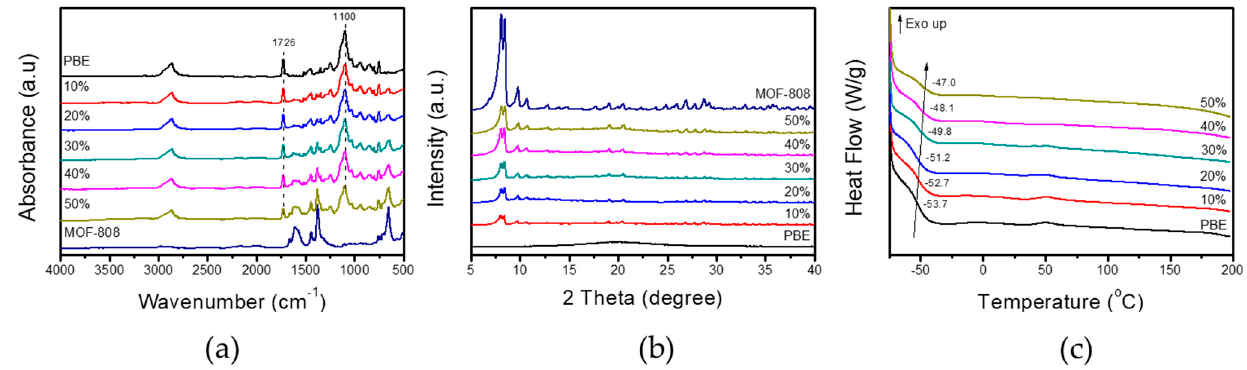
Figure 2. ( a ) FT-IR spectra and ( b ) XRD patterns of the PBE comb copolymer, MOF-808 nanoparti- cles, and PBE/MOF MMMs with different ratios. ( c ) DSC graphs of the PBE copolymer and PBE/MOF MMMs.